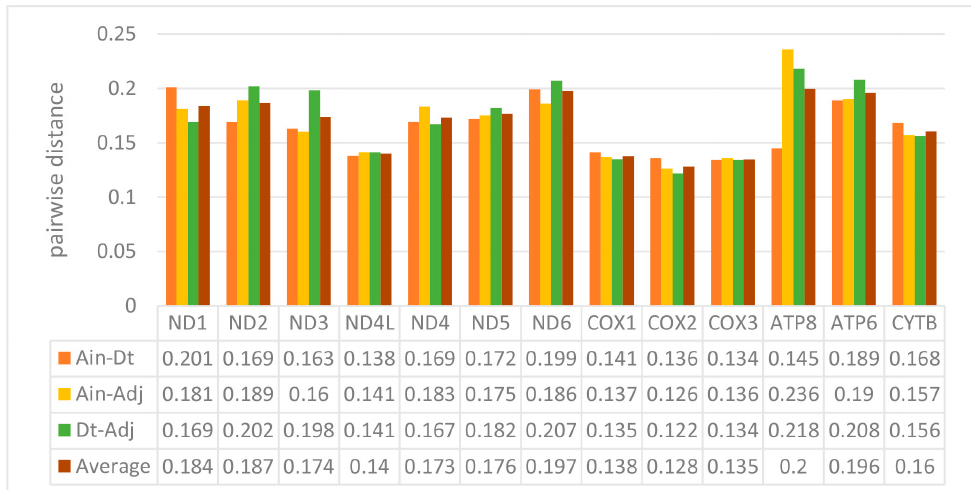
Figure 4. Overall mean p-genetic distances between Alectis indicus ( Ain ), Decapterus tabl ( Dt ), and Alepes djedaba ( Adj ) for each of the 13 PCGs. Note: Values were calculated using the first and second nucleotide positions, the entire codon, and over the full sequence.